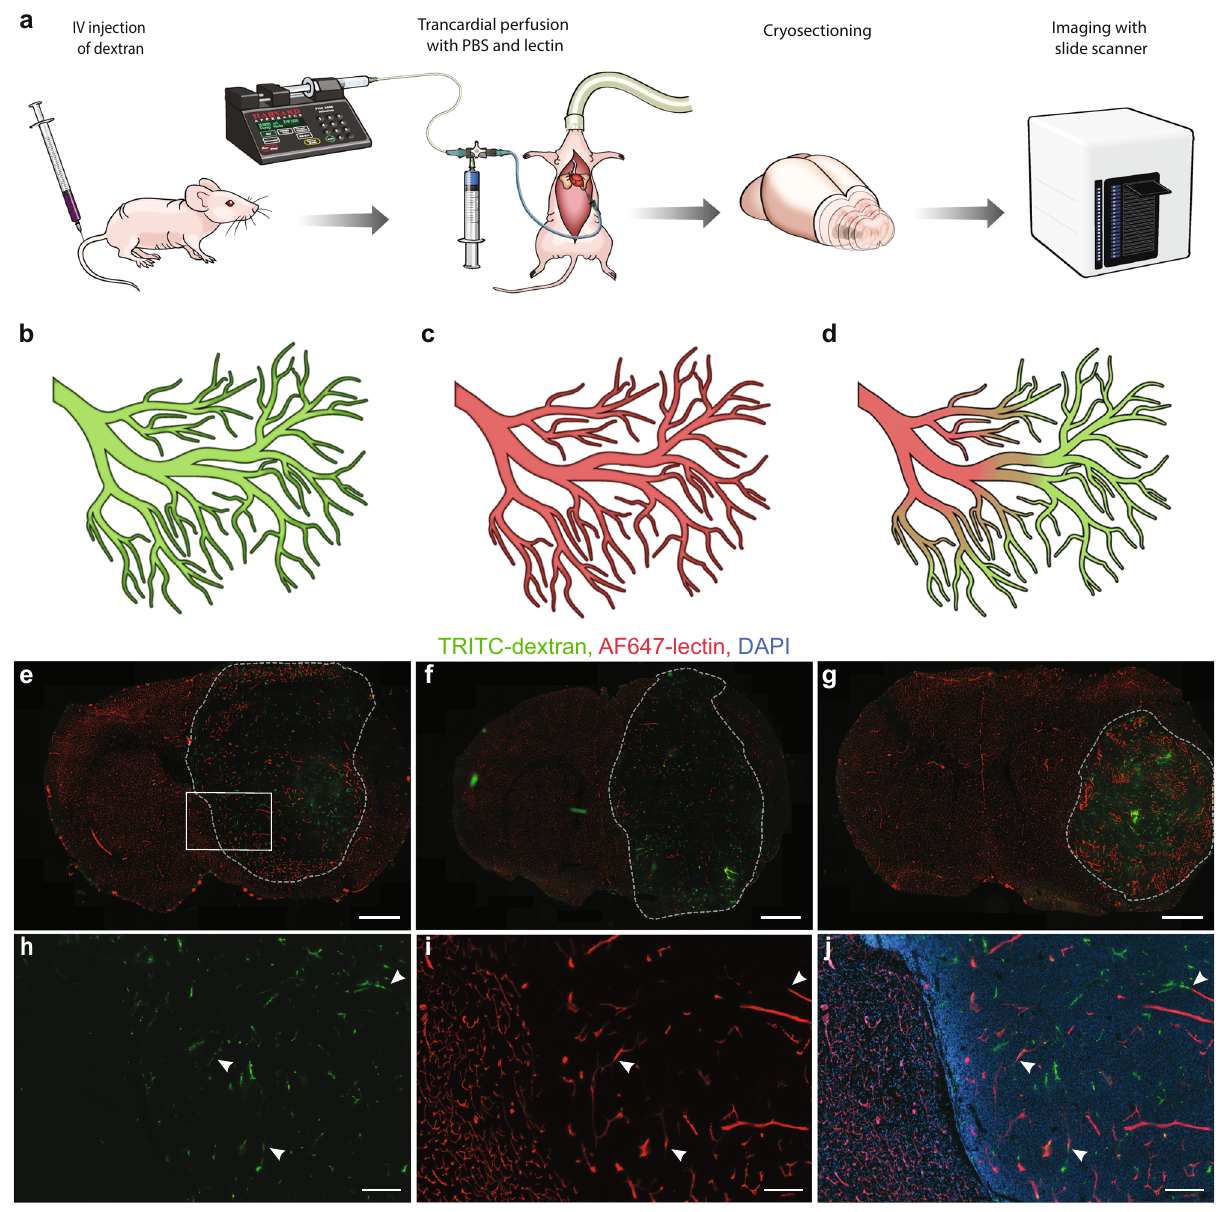
Fig. 2 Measurement of perfusion degree based on fl uorescently labeled probes. a Schematic representation of the experimental setup for studying the degree of transcardial perfusion. b Schematic representation of potential experimental outcomes including full vasculature coverage by TRITC-dextran in a situation with complete inef fi ciency of transcardial perfusion, c full vasculature coverage by AF647-lectin in a situation with successful transcardial perfusion, and d heterogeneous vasculature coverage by both AF647-lectin and TRITC-dextran in a situation with incomplete perfusion of varying degrees. e – g Representative images of coronal brain sections showing homogeneous AF647-lectin labeling of the vasculature in the tumor-free contralateral hemisphere and heterogeneous distribution of fl uorescently labeled probes in the tumor area, illustrating an incomplete perfusion of the tumors arising from G01 ( e ), G06 ( f ), and U87 ( g ) cell lines. Scale bars, 1000 µ m. Tumor borders are highlighted with dashed lines. h – j High-magni fi cation images of the selected area in e . Several examples of transition zones are marked with arrows. Scale bars, 200 µ